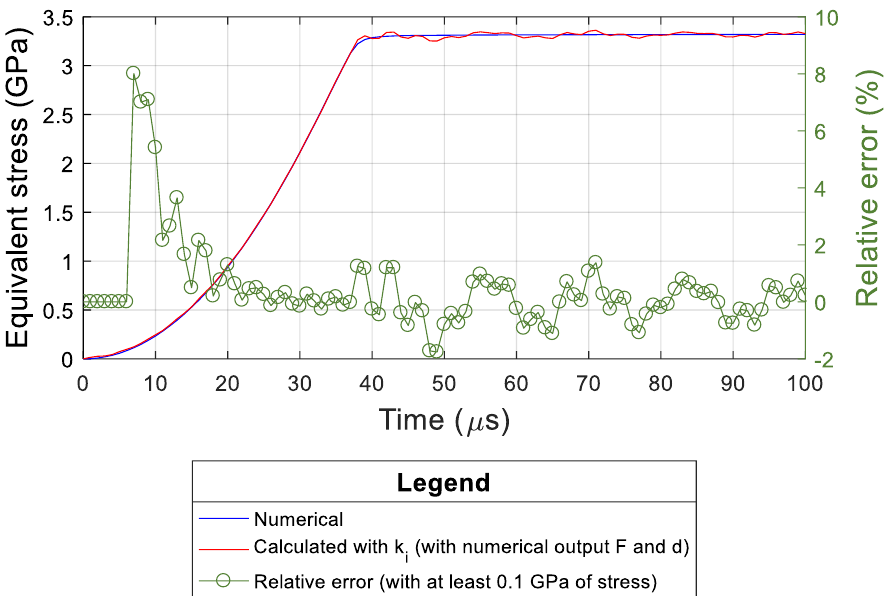
Figure A7. Comparison of σ eq with σ eq,calc. versus time obtained in the shear zone for numerical and processed data.